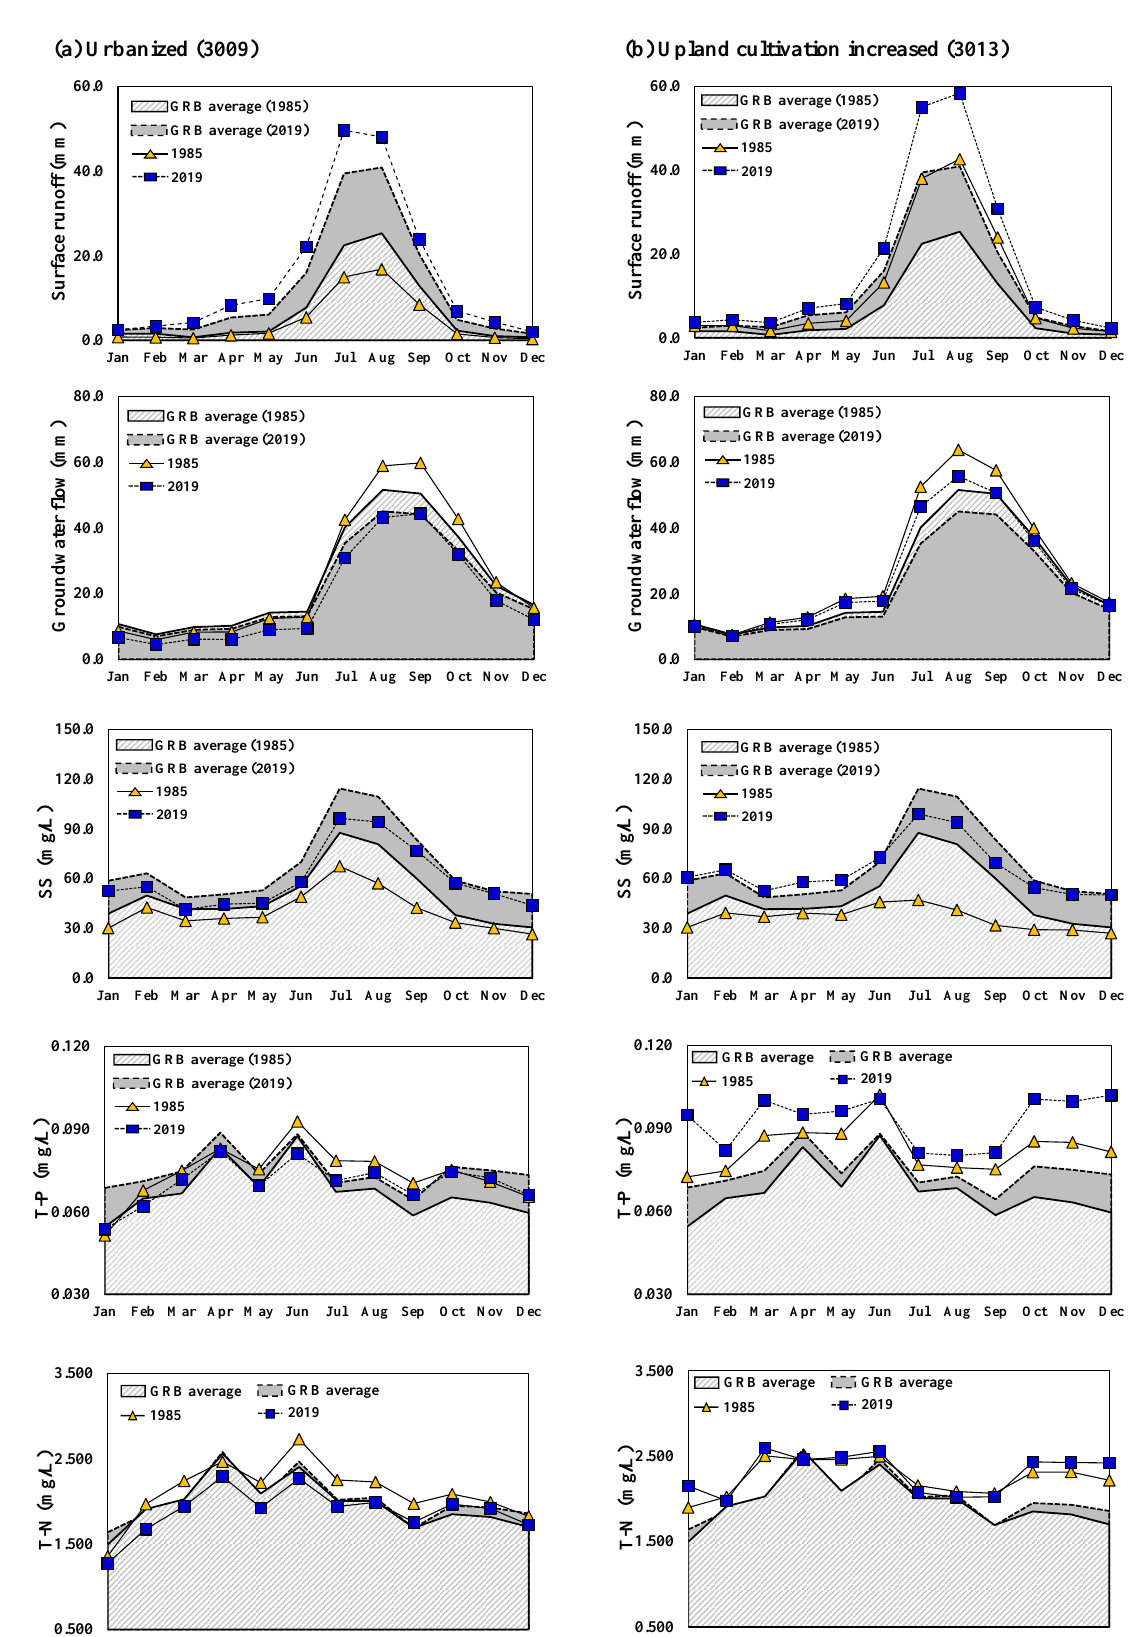
Figure 4. The monthly changes in hydrology and WQ resulting from land-use change.